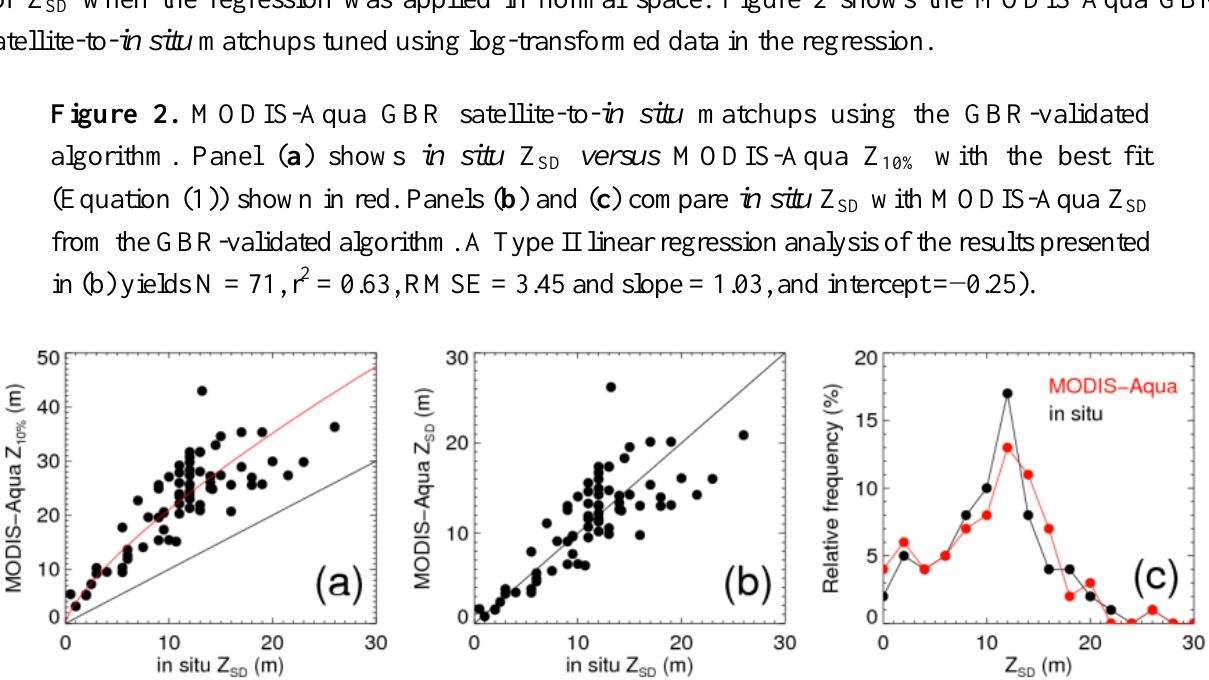
versus MODIS-Aqua Z with the best fit SD 10% with MODIS-Aqua Z SD SD